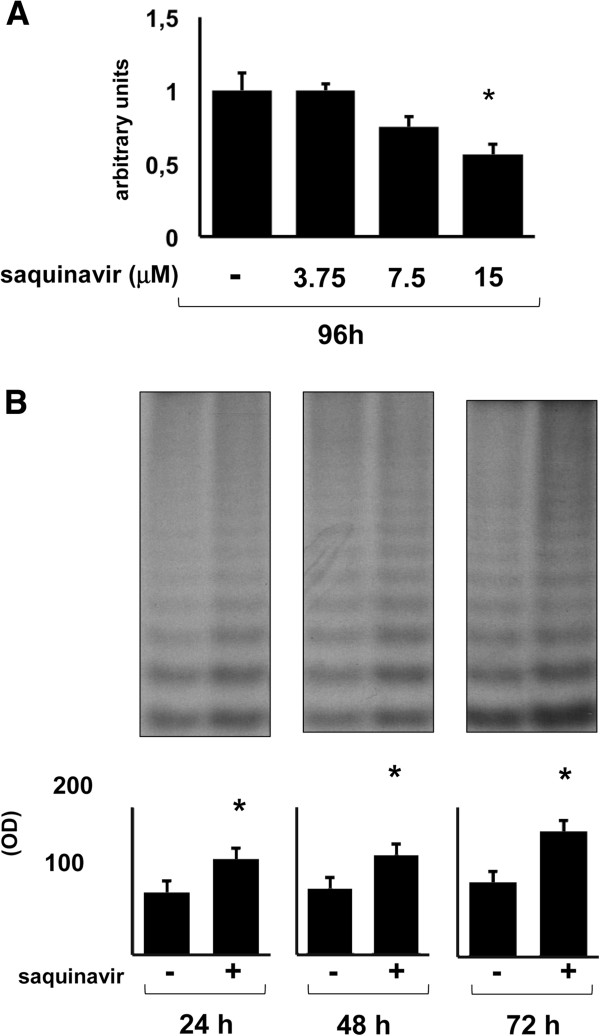
Effect of saquinavir on cell growth and telomerase activity. A. After 96 h, of culture MTT assay was performed as described in “Materials and Methods”, on Jurkat cells treated with saquinavir 3.75, 7.5 and 15 μM or DMSO as control. Saquinavir concentration which inhibited significantly cell viability (15 μM, p < 0,005), was close to the IC50 (i.e. 17. 36 μM, see “Results” section). The data are represented as percentage cell viability of the untreated cells. Each bar represents the mean ± SD of determinations from 3 independent experiments. Asterisk indicates p < 0.05. B. Representative blot of telomerase activity (TRAP Assay) of whole cell extracts from 500 viable Jurkat cells determined 24, 48 and 72 h following treatment with saquinavir. Graph shows the mean ± SD of OD obtained from pooled results of the effect of saquinavir (15 μM) on telomerase activity of Jurkat cell line from 3 separate experiments. All p values were calculated using Student’s t-test. Asterisk indicates p < 0.05.